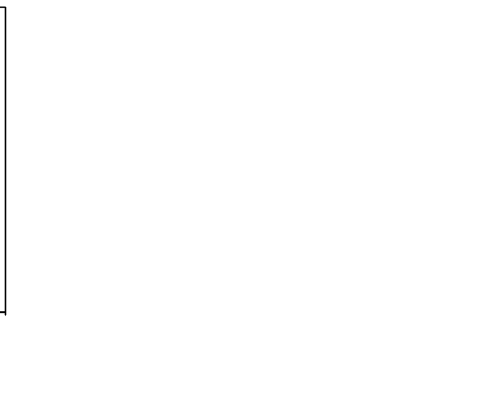
Figure 8. The dependence of D ii on CO 2